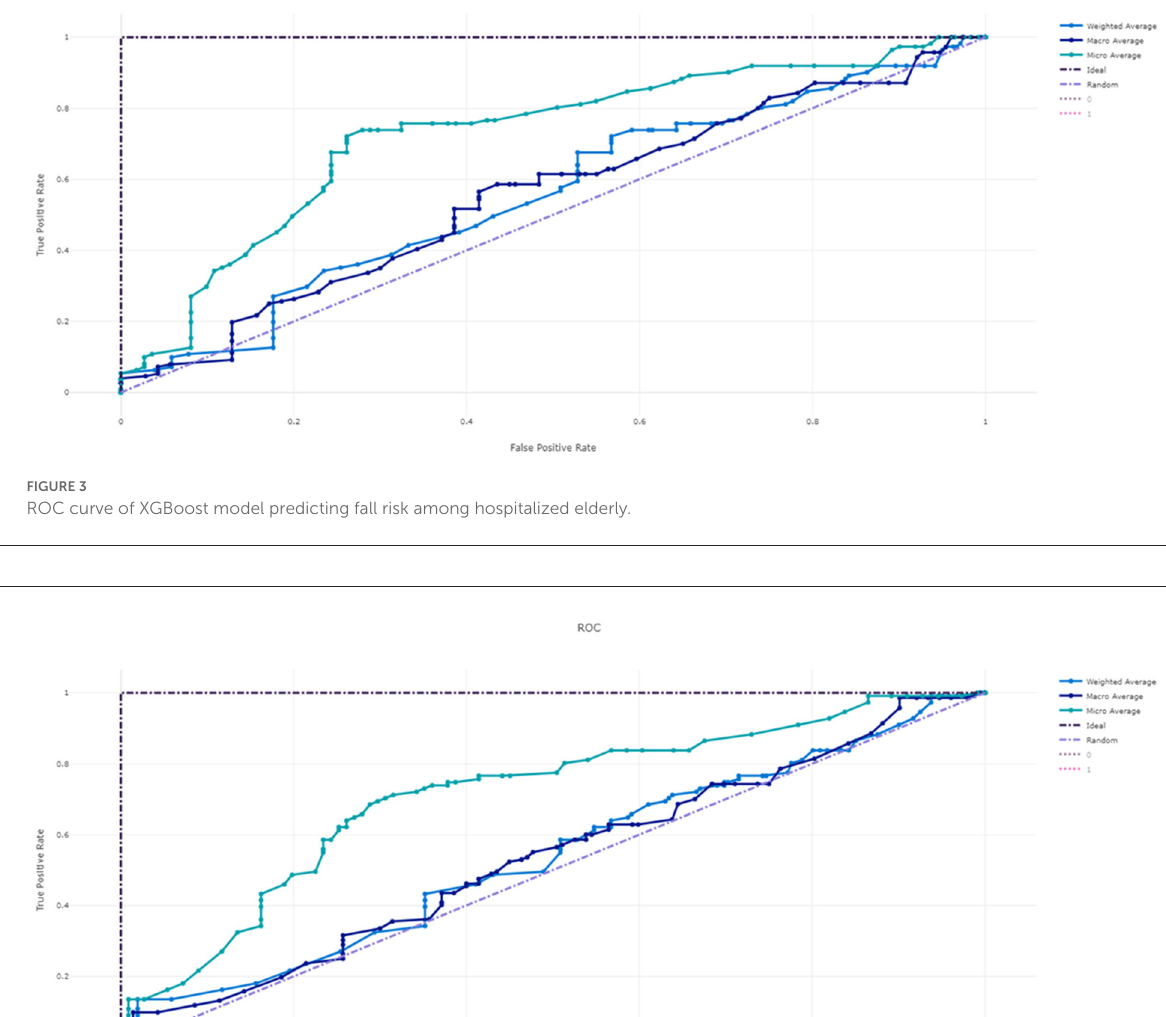
Figure 2. It revealed that with only 15 features, XGBoost